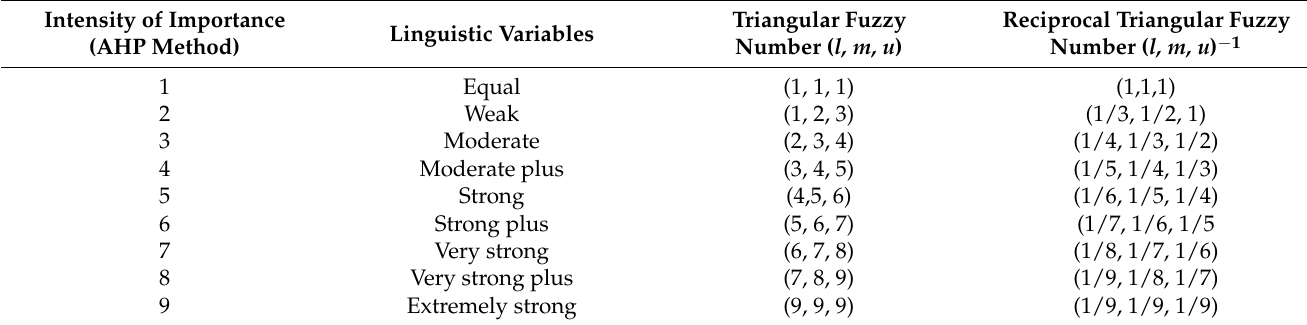
Table 4. Pairwise comparison scale in F-AHP